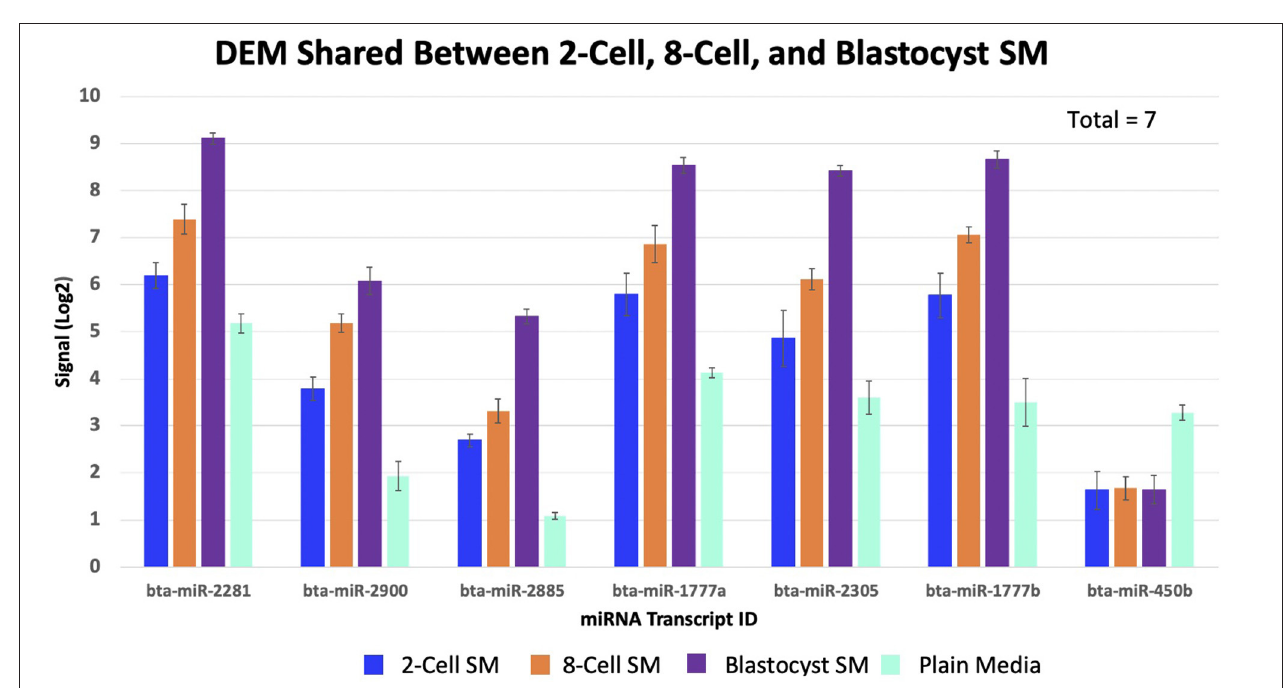
FIGURE 6 | Seven miRNAs were significantly shared between all three spent media conditions. 6 miRNAs increased in levels of up-regulation, while 1 miRNA remained consistently down-regulated (bta-miR-450b).